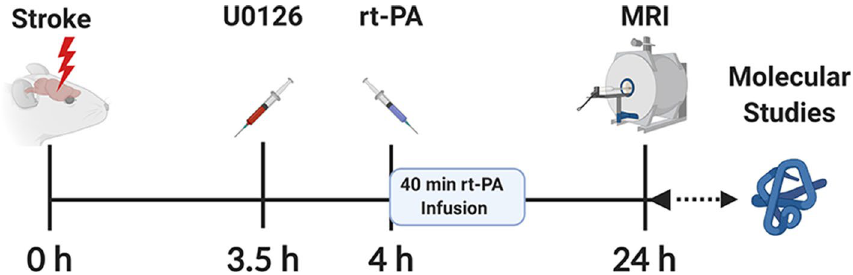
Figure 6. Illustration of the study design is created with BioRender.com. (https:// biore nder.